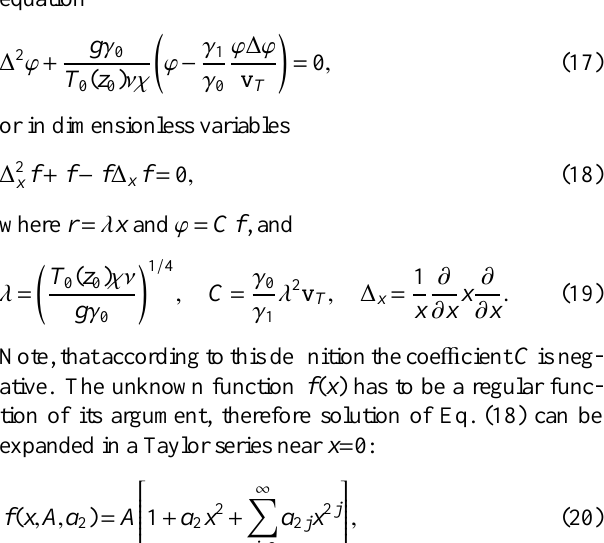
Figure 2. The best approximation of dimensionless poloidal veloc- ity profile f ( x ). The values of the parameters A and a expansion (20) correspond to the position of the peak in Fig. 1.